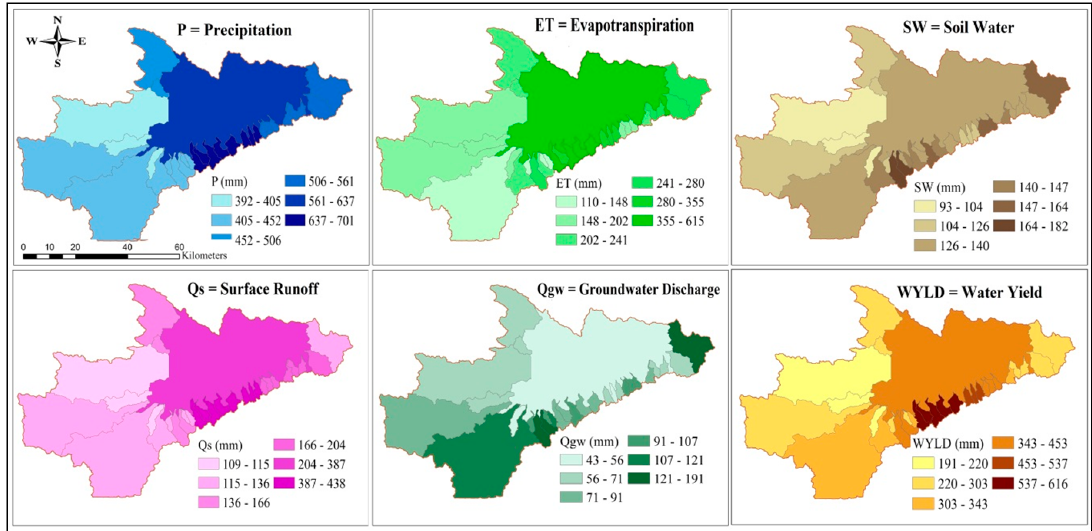
Figure 4. Spatial variations of the water balance components of the Nam Co basin at the subbasin scale.